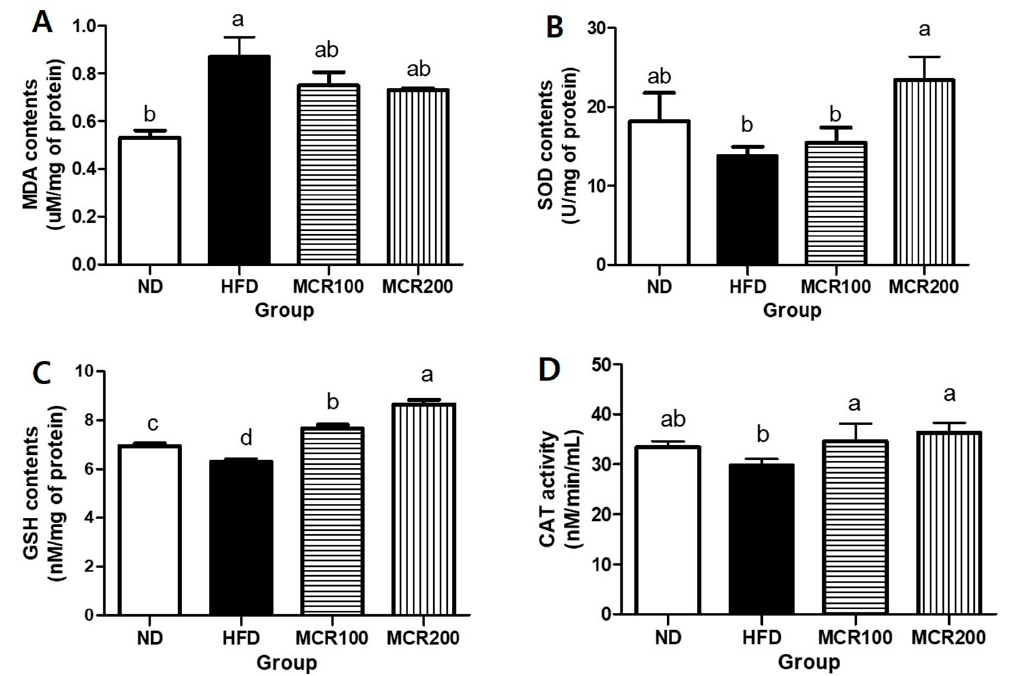
Figure 4. Antioxidant e ff ect of Mori Cortex radicis extract (MCR) on HFD-induced cognitive dysfunction mice. Mice were fed ND or HFD with or without MCR (100 or 200 mg / kg b.w.) for 14 weeks. ( A ) malondialdehyde (MDA), ( B ) superoxide dismutase (SOD), ( C ) glutathione (GSH) contents, and ( D ) catalase (CAT) activity in mouse brain. Results are presented as means ± SDs ( n = 8). Statistical significance was accepted for p values < 0.05. Small letters indicate significantly di ff erent from other groups.